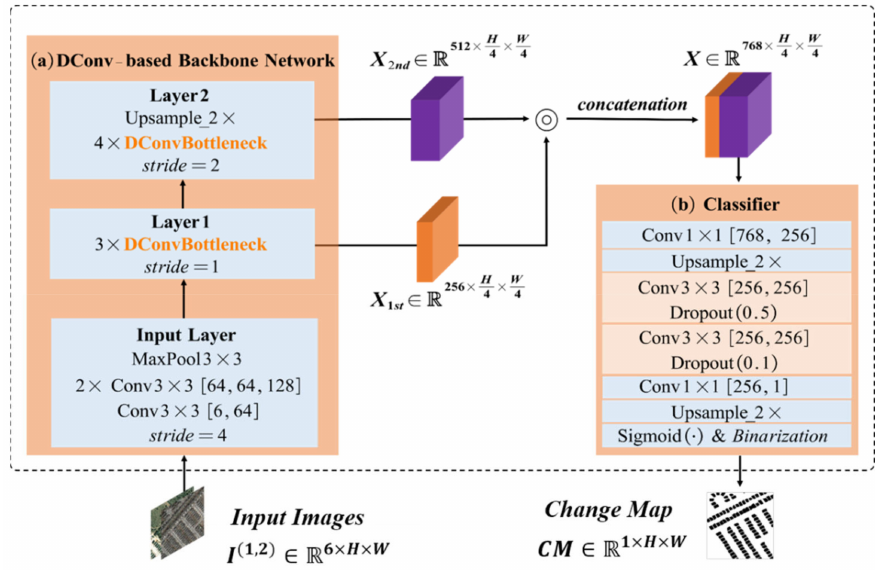
Figure 1. Workflow of the proposed change detection